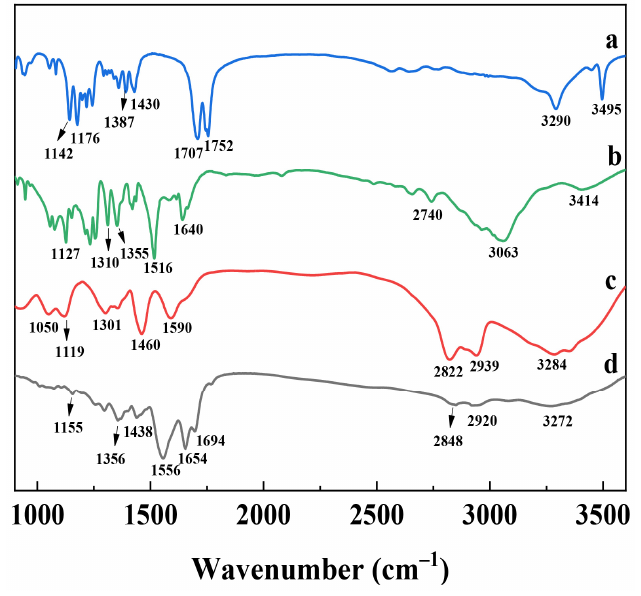
Figure 3. FTIR spectra of ( a ) CA, ( b ) L-Glu, ( c ) PEI, and ( d )